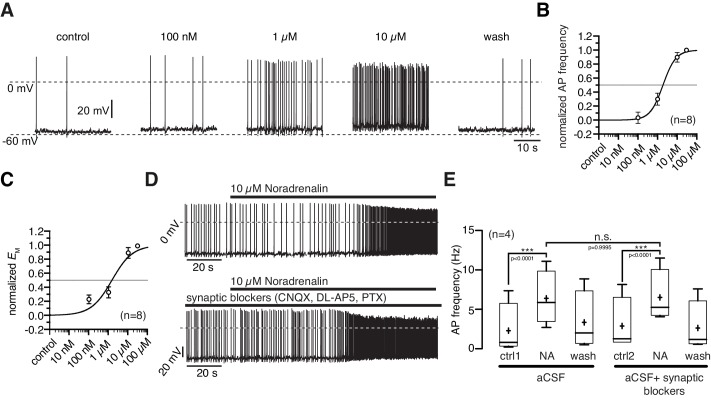
Noradrenergic modulation of NPY/AgRP neurons is concentration dependent.(A) Recording of a NPY/AgRP neuron demonstrating the effect of increasing NA concentrations. (B) and (C) Concentration - response relations showing the NA effect on action potential frequency (B) and membrane potential (C). The curves fit to a sigmoidal relation (Equation 1). NA had an EC50 of 1.9 µM (1.1–3.2 µM; n = 8) for the AP frequency and 1.5 µM (0.8–2.8 µM; n = 8) for the membrane potential, respectively. (D) and (E) The NA modulation of NPY/AgRP neurons is direct and not dependent on synaptic input. Original recording (D) and averaged effect on action potential frequency (E) showing that the NA effect on NPY/AgRP neurons is not changed when glutamatergic and GABAergic synaptic input is blocked. Experiments in (E) were performed consecutively with the same set of neurons (n = 8). Control 1 and control two refers to the different starting conditions, that is preincubation with or without synaptic blockers. ***p<0.001, one-way ANOVA with post hoc Tukey analysis.